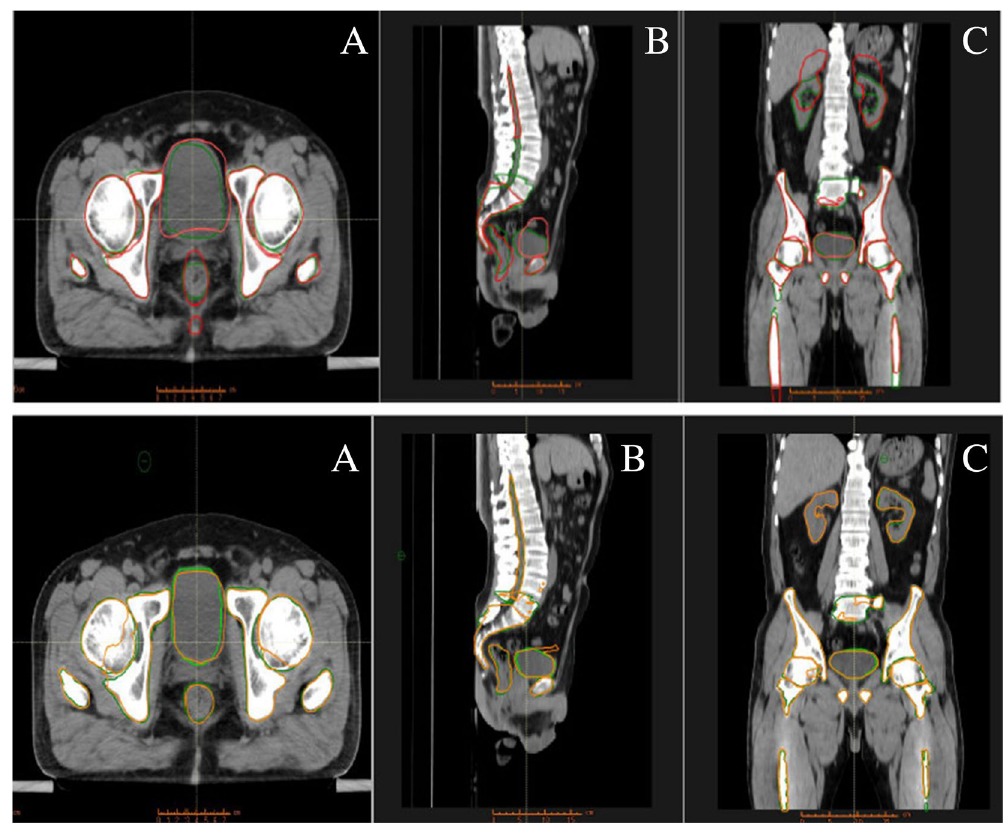
Figure 1. Comparison of OAR results of rectal cancer patients using two software. [( A ) is the traverse plane, ( B ) is the sagittal plane, ( C ) is the coronal